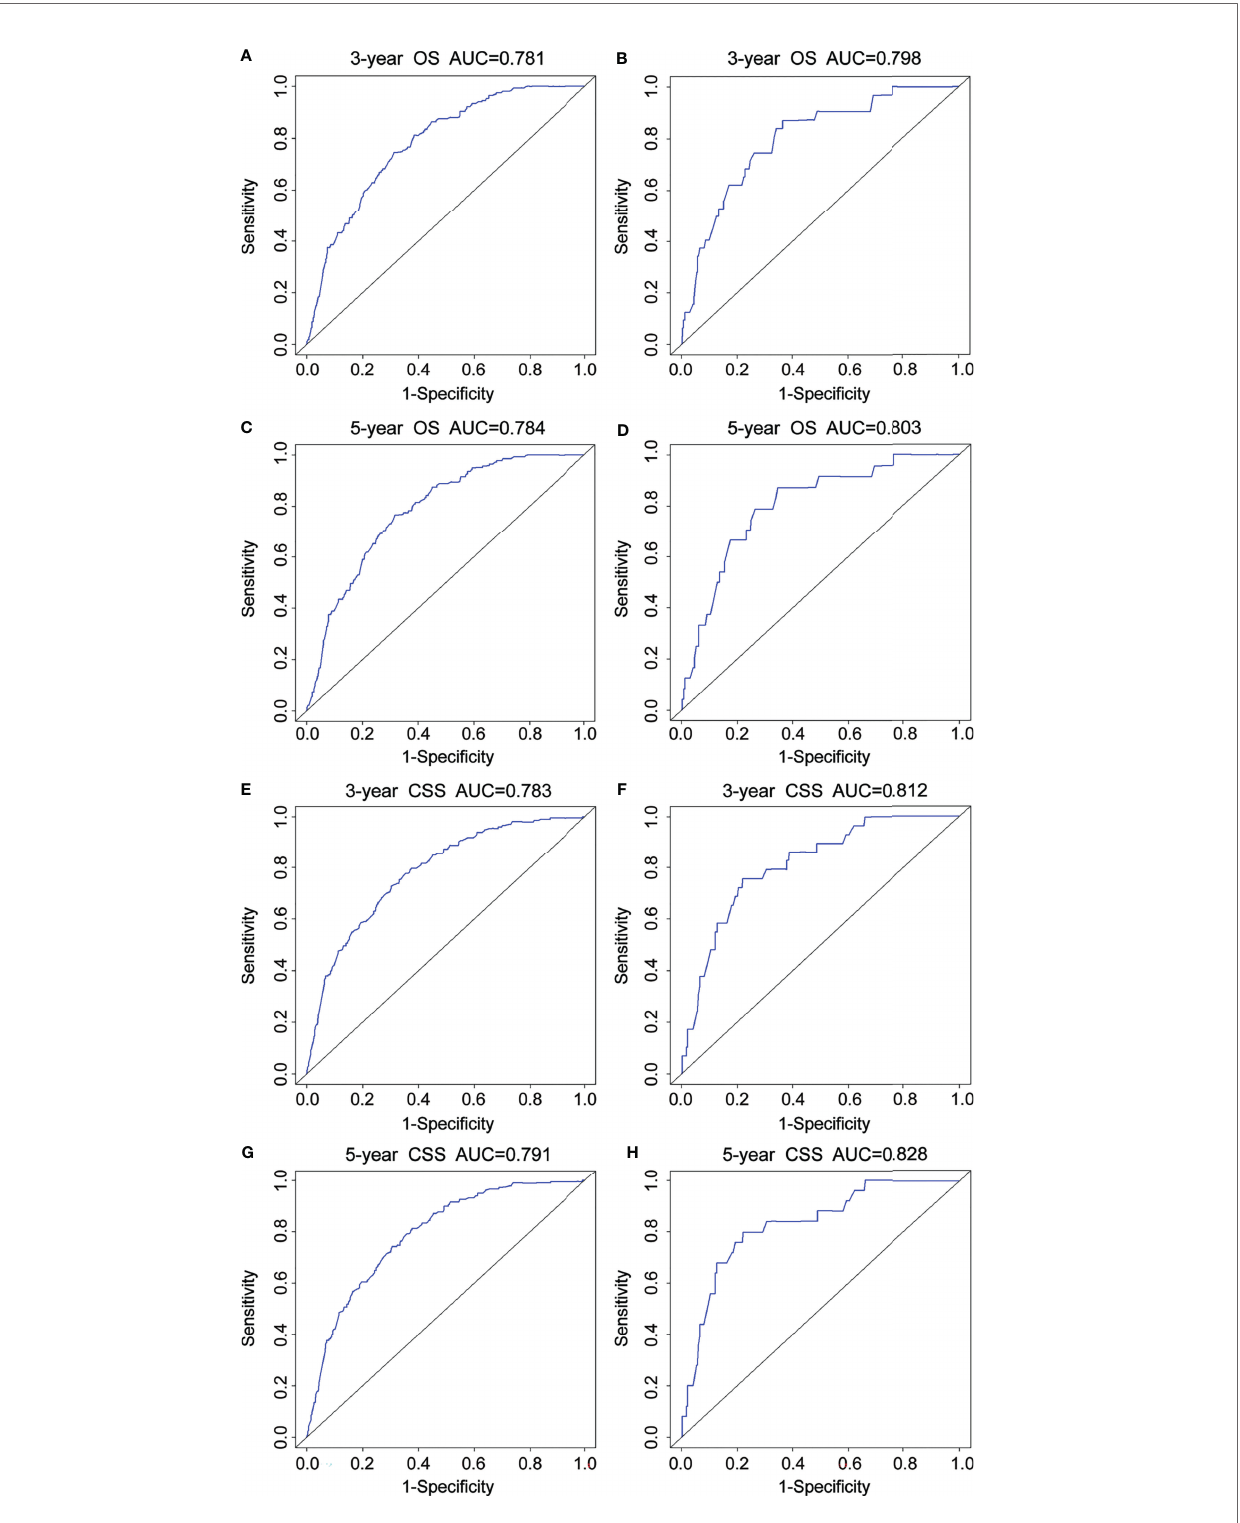
FIGURE 5 | ROC curves for 3- and 5-year OS and CSS of the prognostic nomograms. ROC curves for 3- and 5-year OS in the training cohort (A, C) and the validation cohort (B, D) . ROC curves for 3- and 5-year CSS in the training cohort (E, G) and the validation cohort (F, H) . OS, overall survival; CSS, cancer-speci fi c